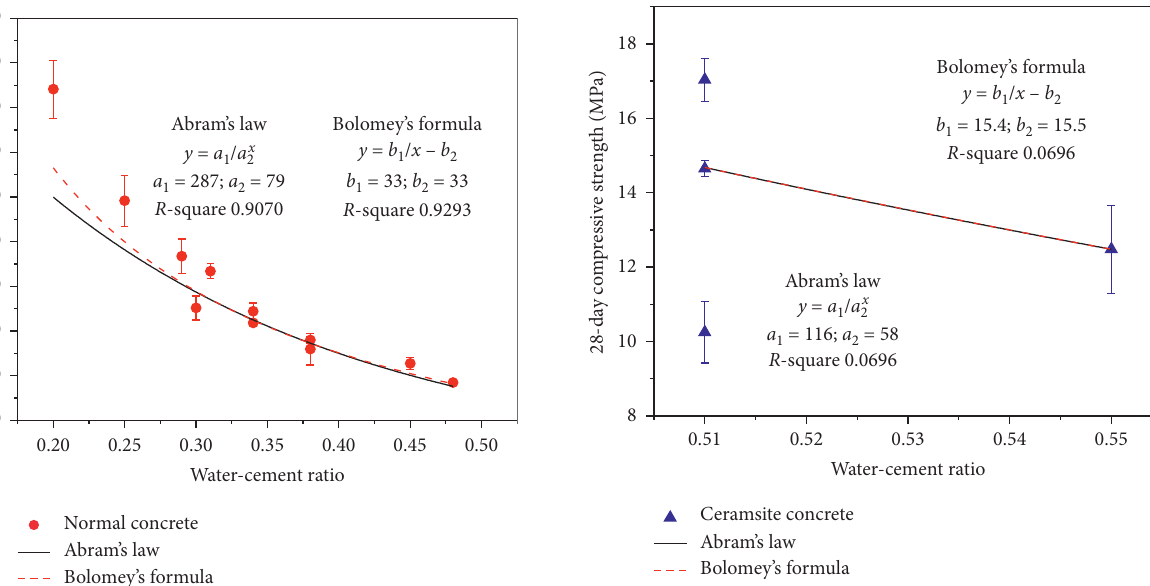
Figure 5: Simulations of Abrams’ law and Bolomey’s formula for ceramsite concrete.